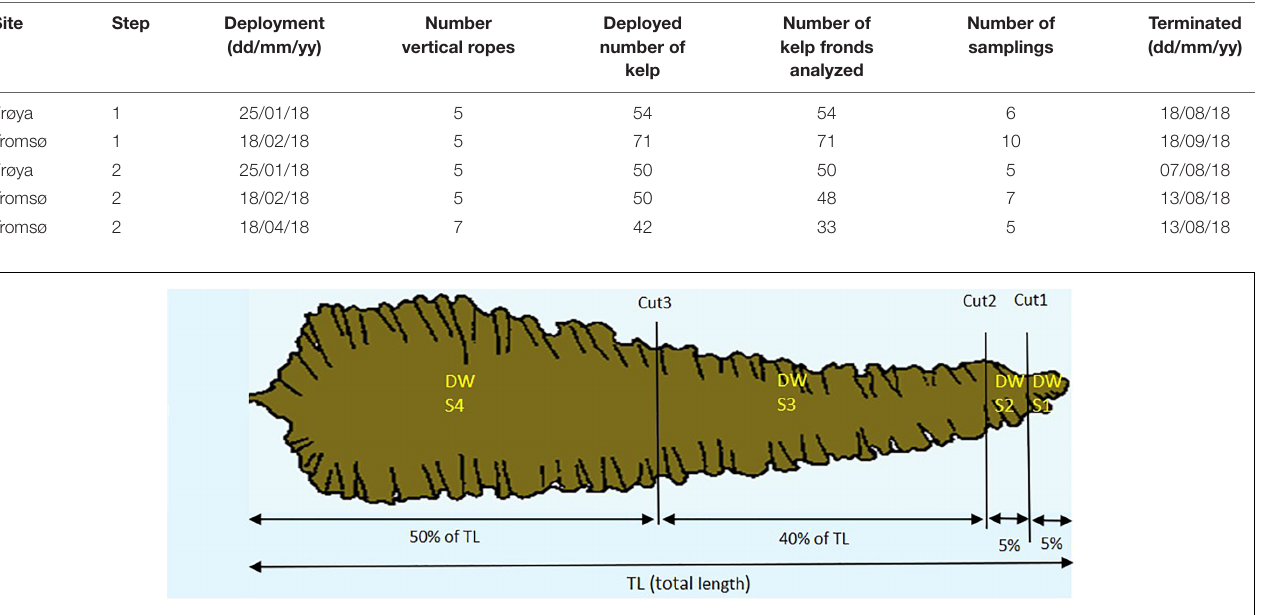
TABLE 1 | Experimental groups, categorized according to date of deployment and sampling